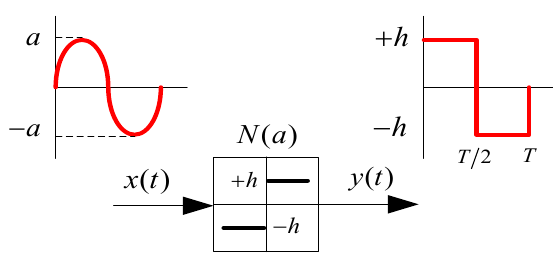
Figure 7. The diagram of the ideal relay.